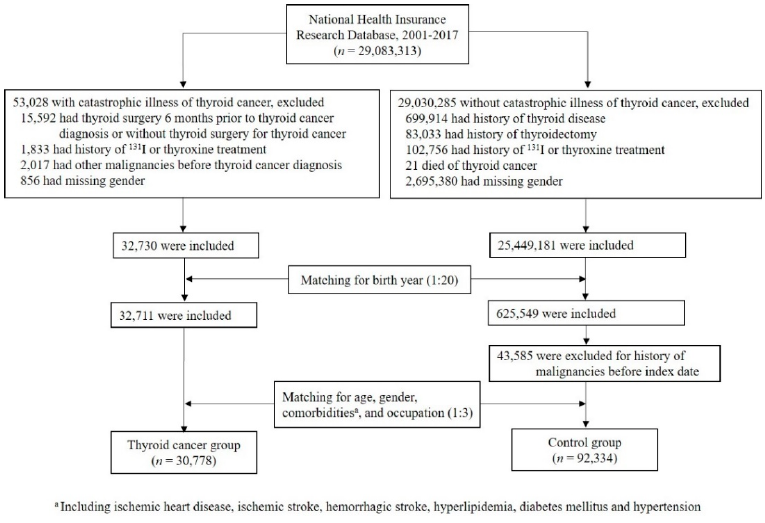
Figure 1. Flow chart of study populations. The thyroid cancer group consisted of 6,581 males and 24,197 females, with a median age of 47 years (IQR: 37–56 years) at the time of thyroid cancer diagnosis (Table 1). Patients with a history of ischemic heart disease, ischemic stroke, and hemorrhagic stroke